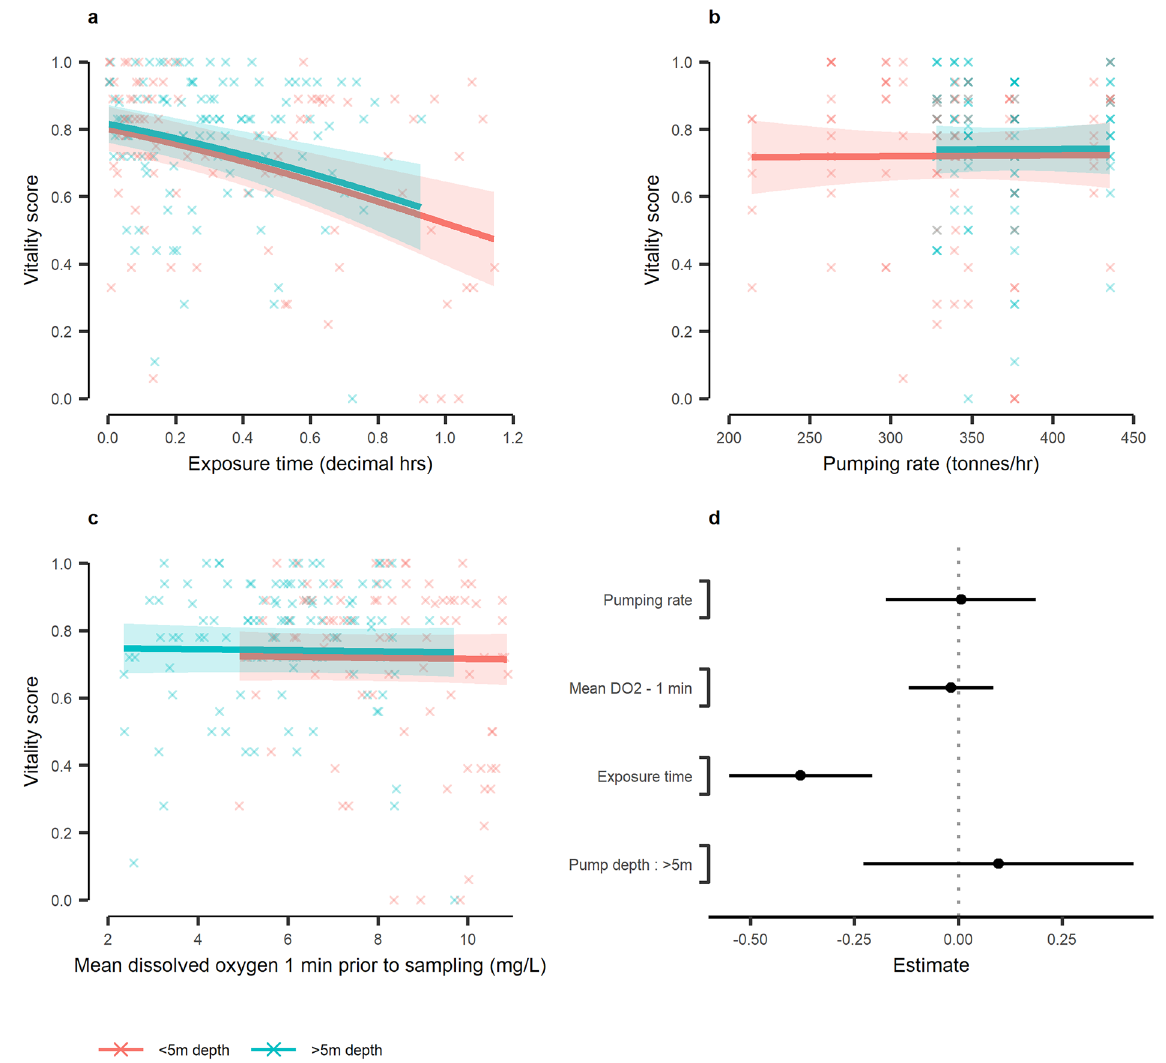
Figure 7. The model derived relationship between vitality scores and various drivers during crowding-related pumping of Atlantic mackerel ( Scomber scombrus ) during commercial purse seine capture. The model fits were constructed from averaging of three top competing models selected by Akaike information criterion. Fish were collected throughout crowding (after being pumped onboard) and assessed for behavioural vitality. ( a ) The relationship with crowding exposure time, for the mean pumping rate (351 tonnes/h) and mean dissolved oxygen (DO 2 ) in the net during the previous 1 min prior to vitality sampling (6.95 mg/L). ( b ) The relationship with pumping rate, for the mean exposure time (0.33 h) and mean DO 2 . ( c ) The relationship with DO 2 in the net during the previous 1 min prior to vitality sampling, for the mean exposure time and mean pumping rate. The shaded area indicates the model derived 95% confidence interval, with the underlying data indicated as crosses. All relationships are factorised according to pump depth (either < 5 m depth or > 5 m depth). ( d ) Model coefficients (black points) for the averaged model, with 95% confidence intervals as whiskers. The dotted grey line indicates zero effect. All continuous model covariates were scaled prior to